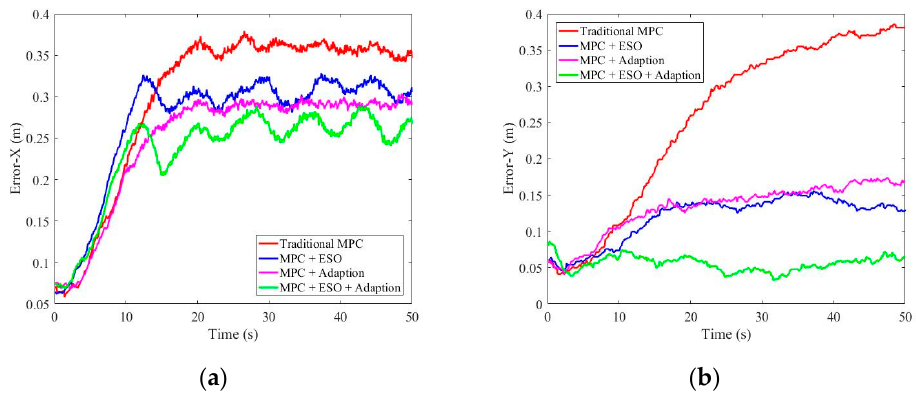
Figure 18. The simulation results for robot trajectory tracking. ( a ) The trajectory error in the X direction; ( b ) The trajectory error in the Y direction. Table 4. The average errors of the whole process with 0.2 m/s disturbance velocities in the Y direction. Mean